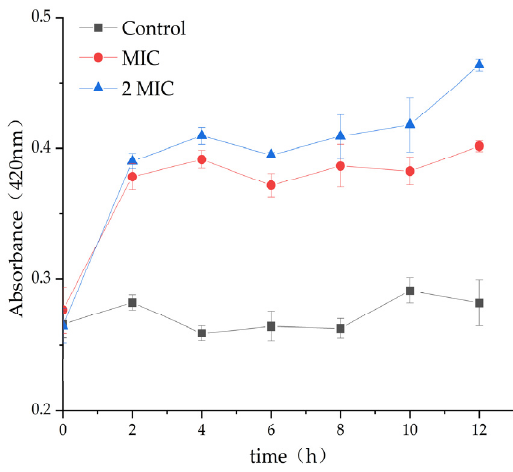
Figure 5. Effect of MA on the content of S. aureus β -galactosidase.